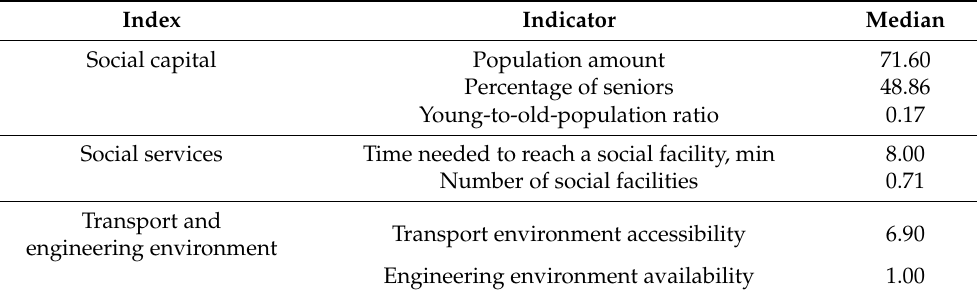
Table 3. List of indicators for monitoring rural settlement development.